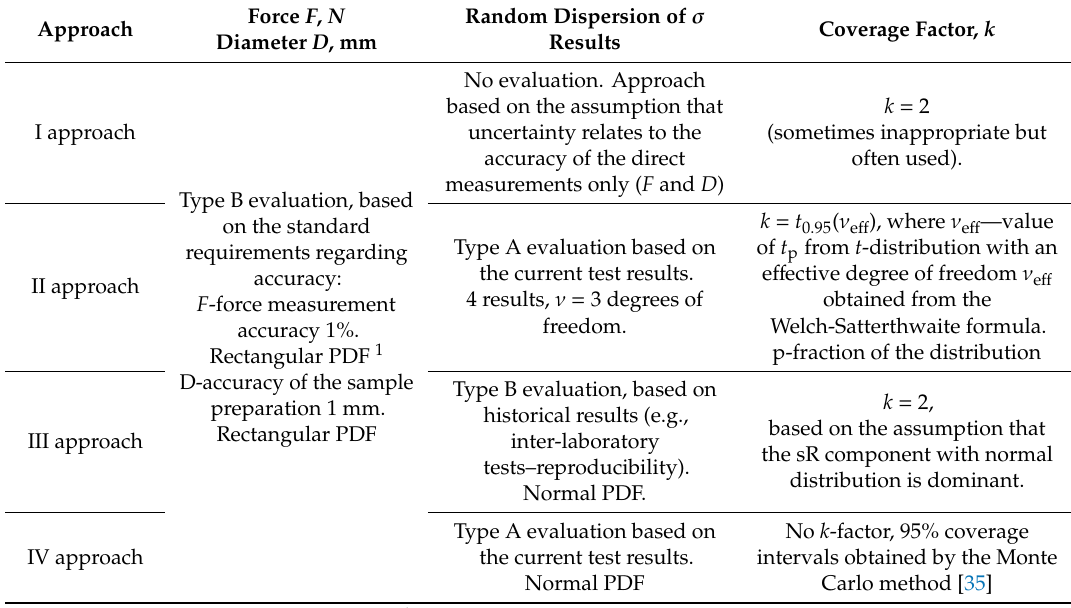
Table 2. Four example-approaches to uncertainty